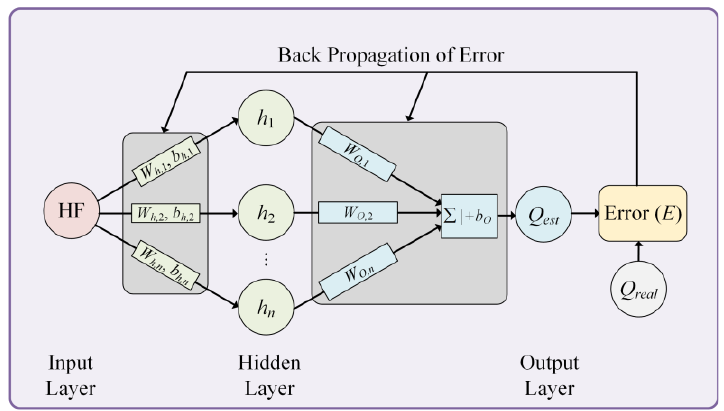
Figure 15. Schematic diagram of a three-layer BPNN.